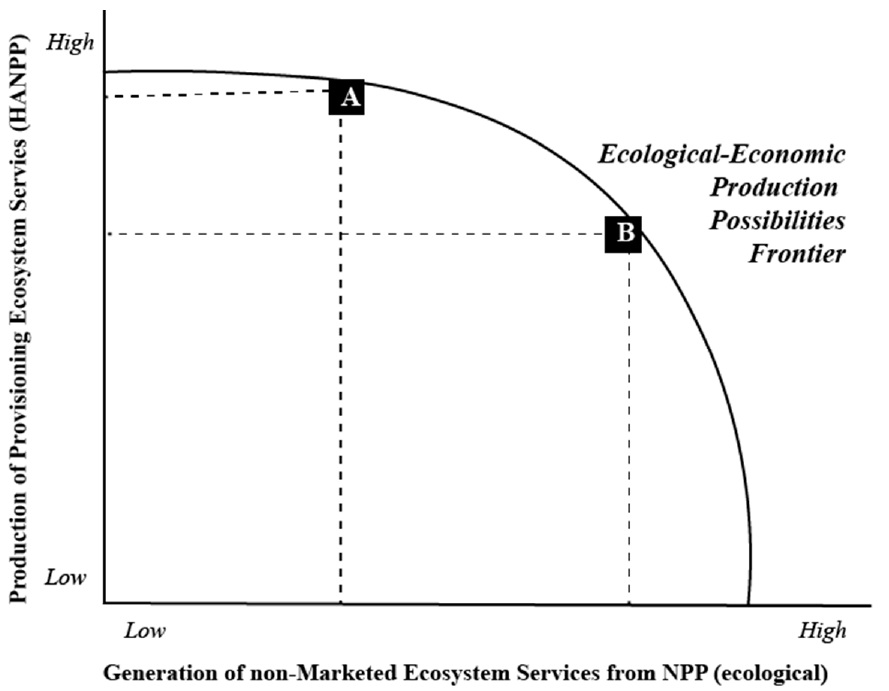
Figure 2. An ecological–economic production-possibility frontier where marketed provisioning ecosystem services trade-off against non-marketed supporting and regulatory ecosystem services (Adapted with permission from [28], 2013, Elsevier).